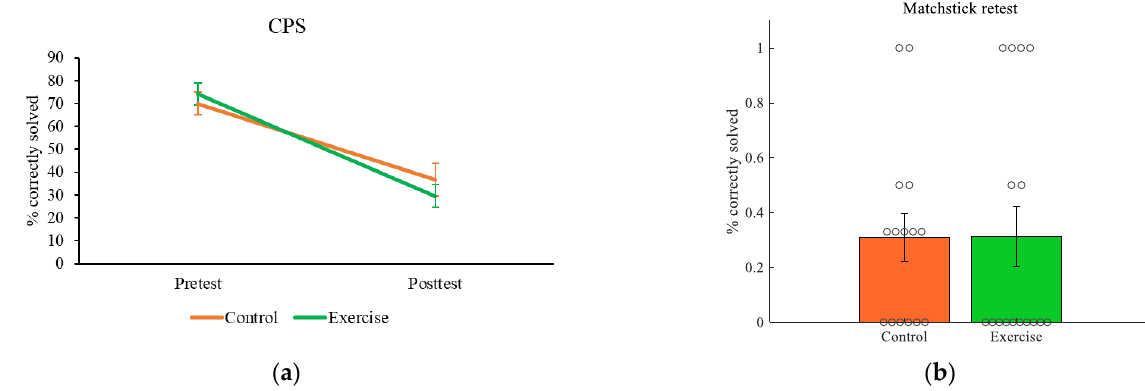
Figure 4. Exercise effect on convergent thinking. ( a ), CPS; ( b ), matchstick re-test. Data shown as means ± SE, circles represent individual responses.